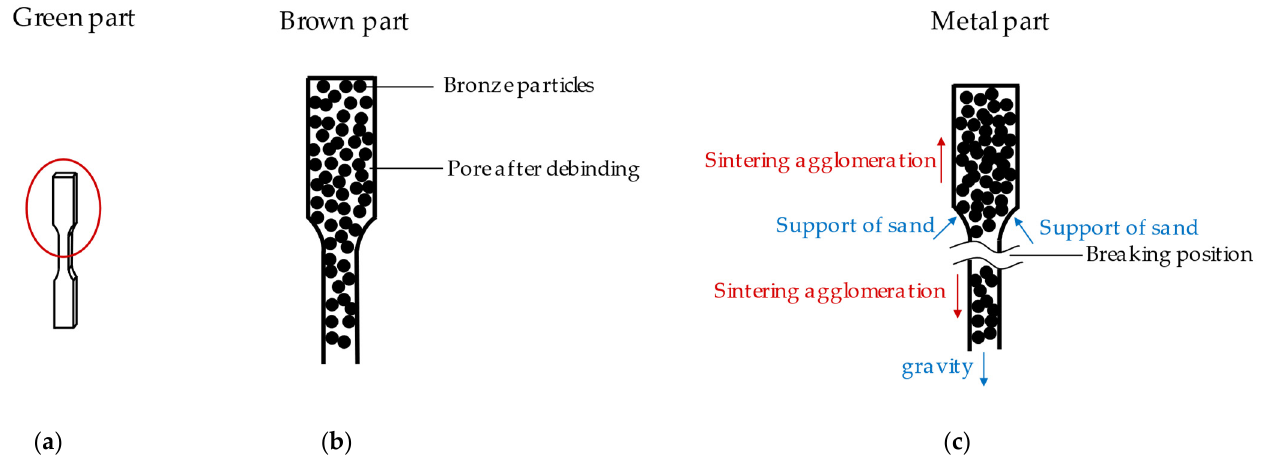
Figure 8. Diagram of fracture mechanism of vertical sintered parts: ( a ) green part; ( b ) brown part. PLA vaporized and only bronze particles remained in the part; ( c ) metal part. Material fracture caused by uneven distribution of sintering concentration, gravity, and sand support effect.